Question: Is the quantity shown trending increasing or decreasing?
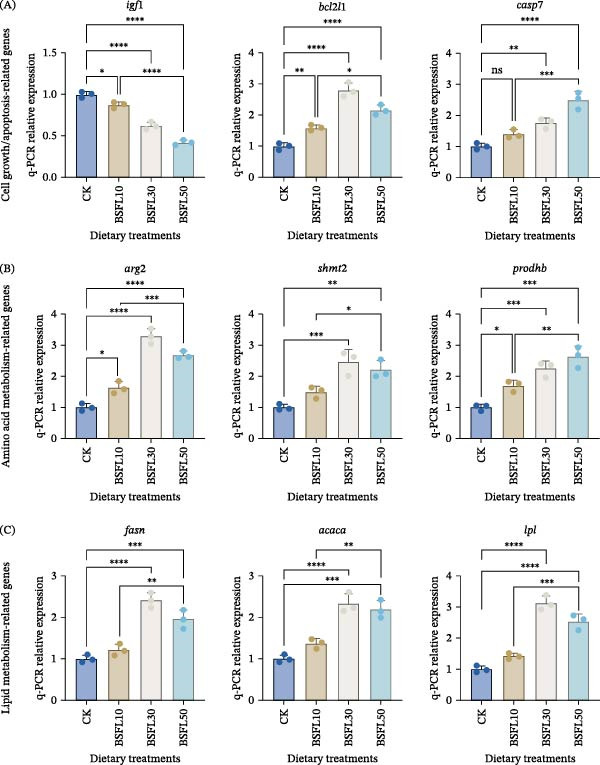
Answer: increasing